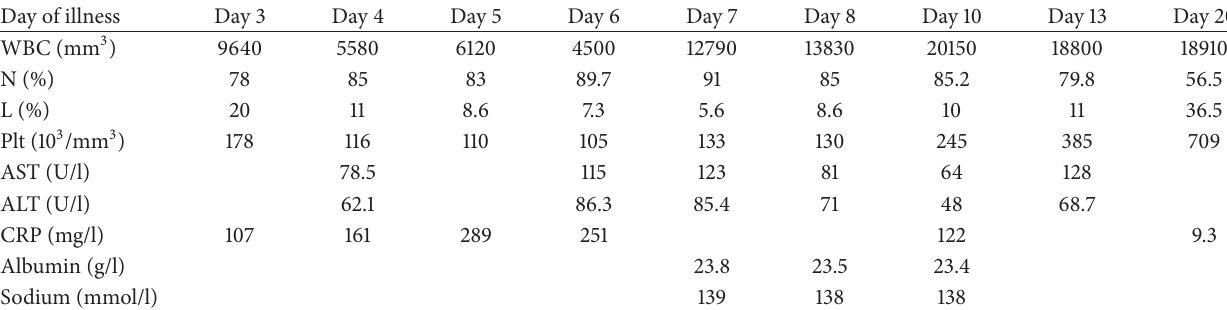
Table 1: Summary of investigations.